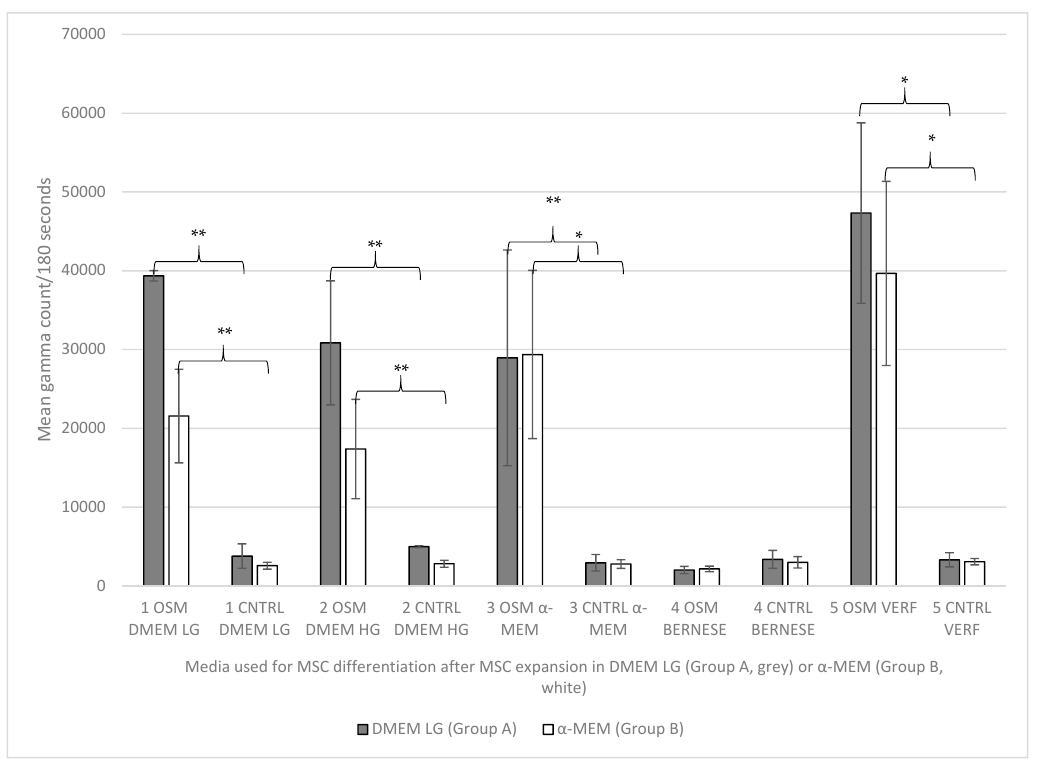
Figure 3. Descriptive statistics for the tracer uptake (gamma count mean values +/ − SD) for all groups. The grey bars reflect the use of expansion media A (DMEM LG) and the white bars reflect the use of expansion media B ( α -MEM) prior to differentiation, according to the designated group (1–5). OSM = osteogenic media, CNTRL = negative control group. Significance: ** = p ≤ 0.01; * = p ≤